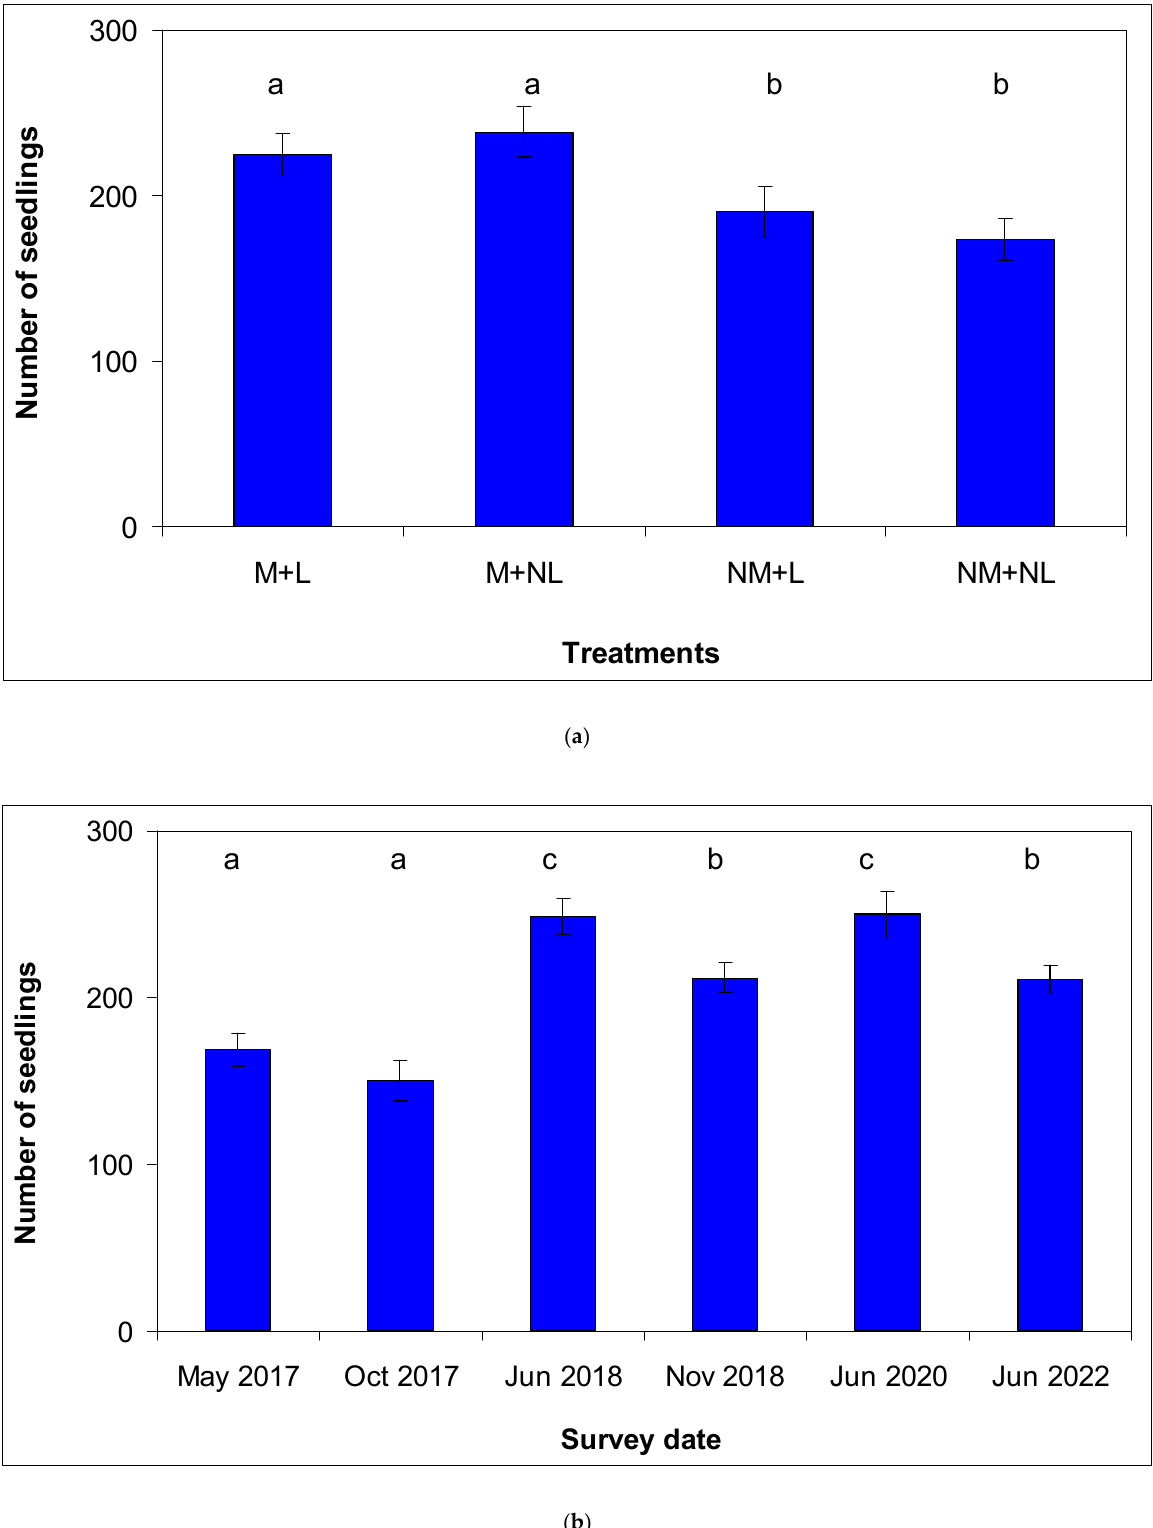
Figure 1. Number of seedlings of Pinus halepensis Mill. (mean ± standard deviation) averaged among treatments ( a ) and survey dates ( b ). Different letters indicate significant differences according to the LSD test ( p < 0.05). Legend: M + L = Mulching + Logging; NM + L = No Mulching + Logging; NM + NL = No Mulching + No Logging; M + NL = Mulching + No Logging.